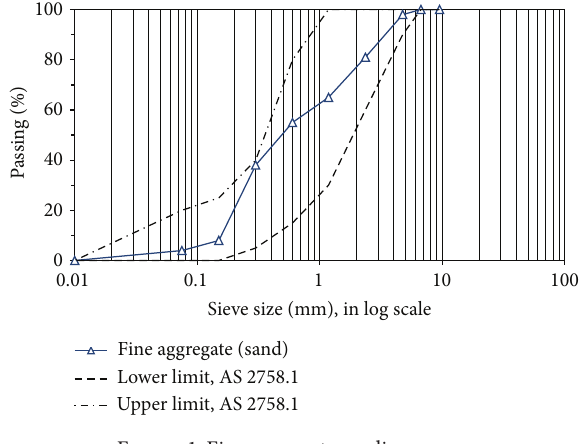
Figure 1: Fine aggregate grading